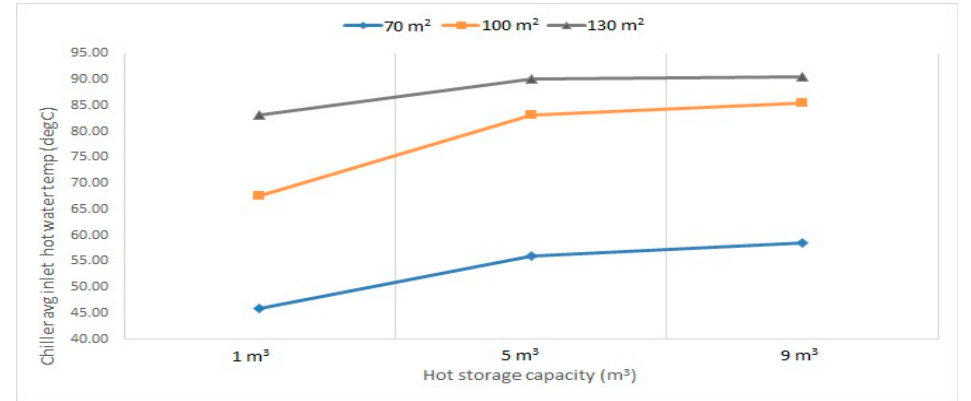
Figure 9. Chiller average inlet hot water temperature at 0.6 kg/s for different hot storage capacities and solar collector areas (collector–HW tank–chiller) pumps flow rates.